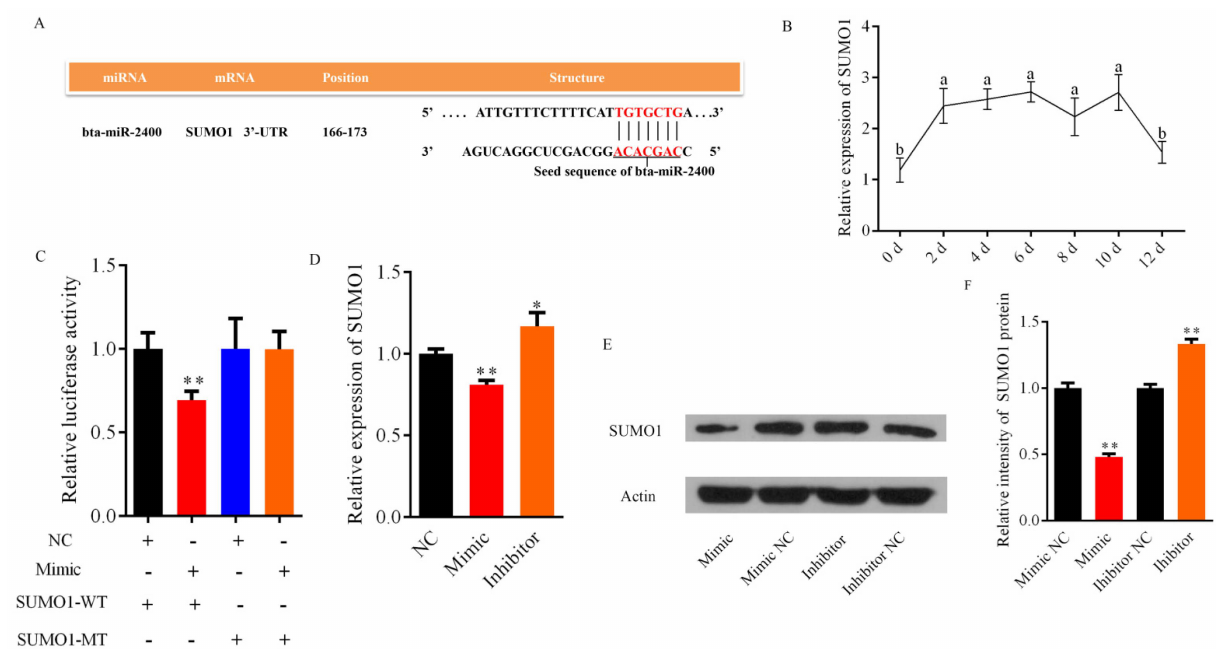
Figure 4. Bta-miR-2400 targets the 3 (cid:48) UTR of SUMO1. ( A ) The schematic of the sequence alignment between bta-miR-2400 and 3 (cid:48) UTR of SUMO1. ( B ) The expression pattern of bta-miR-2400 during yak adipocyte differentiation. ( C ) Luciferase reporter assay for bta-miR-2400 and 3 (cid:48) UTR of SUMO1. ( D – F ) Expression of SUMO1 mRNA and protein for cells transfected with bta-miR-2400 mimics, inhibitors and negative control. * p < 0.05; ** p < 0.01. Different lowercase letters represent significant differences ( p <